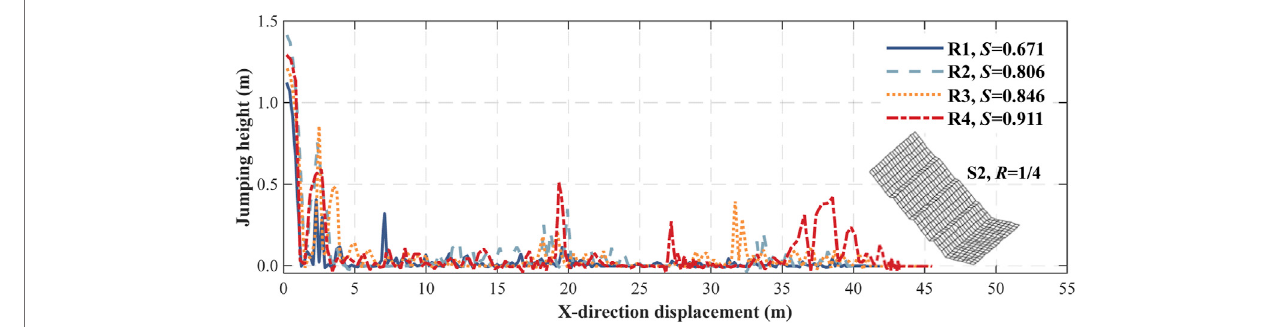
FIGURE 8 | Jumping height along the x -direction.